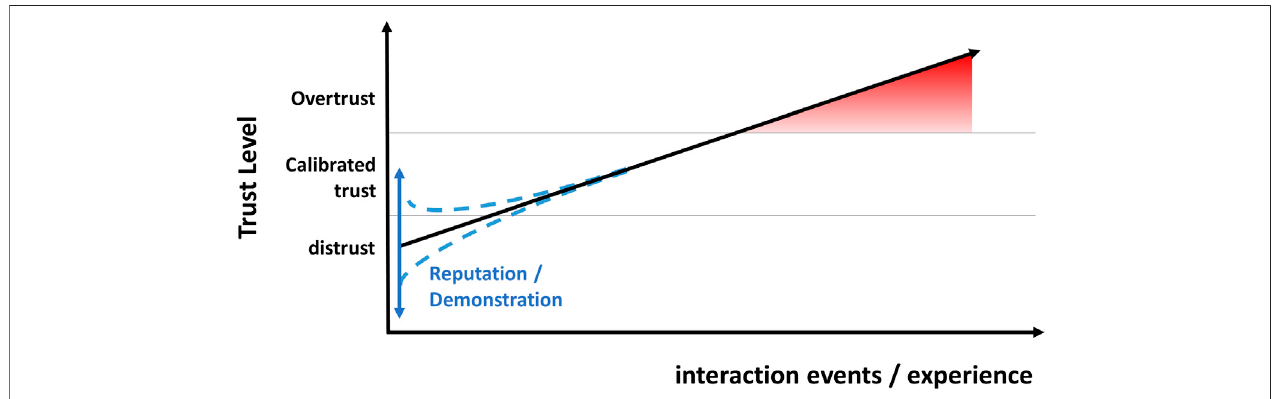
FIGURE 6 | Development of trust beyond system